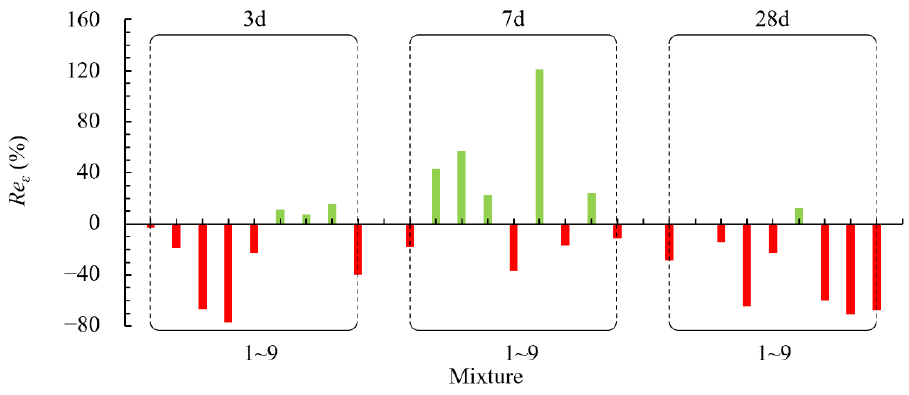
Figure 9. Re ε of RSCPB for 3 days, 7 days, and 28 days curing ages.